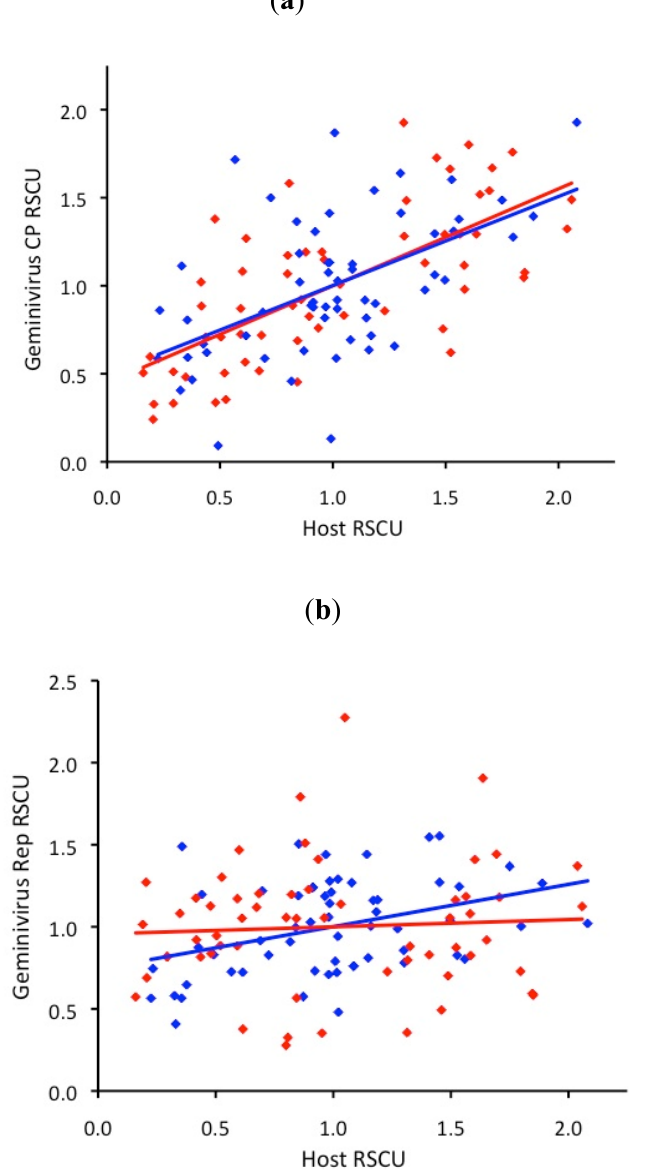
Figure 3. Correlation between relative synonymous codon usage (RSCU) of (a) geminivirus CP and (b) geminivirus Rep and host RSCU for eudicot-infecting begomoviruses (blue) and monocot-infecting mastreviruses